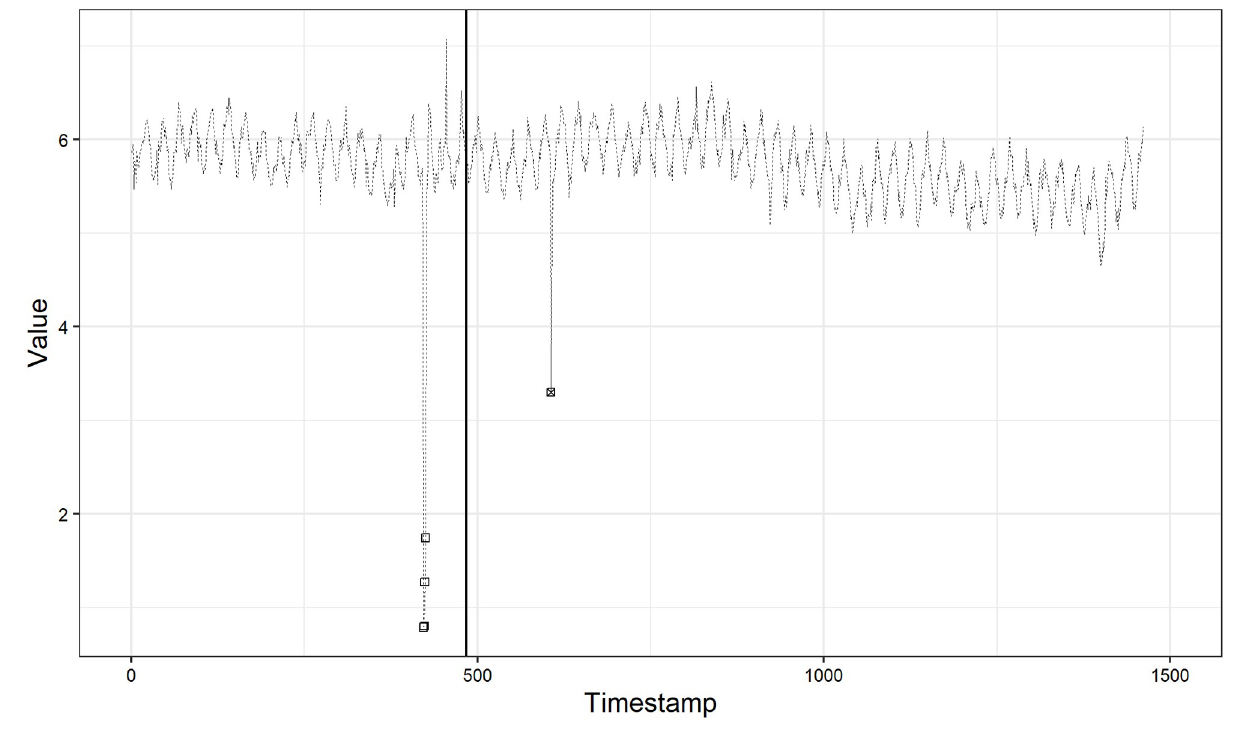
Fig 3. Anomaly detection result on time series